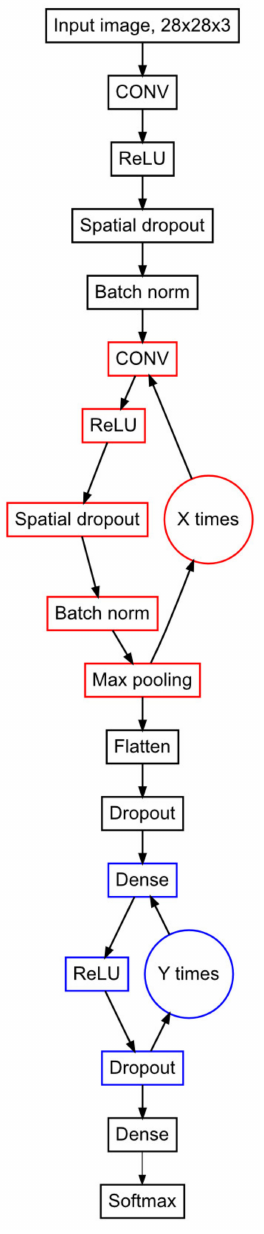
Figure 2. Flowchart of the convolutional neural network (CNN) model. CONV is a 2D convolutional layer with a L1 regularization factor of 1e-4. ReLU is the rectified linear activation function. Spatial dropout is a 2D spatial dropout layer, dropping entire 2D feature maps. Batch norm is a batch normalization layer, normalizing the activation of the previous layer at each batch. Numbers of iterations (X) of the convolutional layers loop (red) is defined by the Bayesian optimization (Table S4, convolutional loop iterations). For every iteration, the number of filters of the loop is doubled. The first and potentially second convolutional layers loop contains a 2D max pooling layer of size 2 × 2. The data are flattened (Flatten) after the convolutional layers loop. Individual element dropout (Dropout) is applied for the rest of the model. The dense layers loop (blue) applies a L2 regularization factor of 1e-4. The number of iterations (Y) of the dense layers loop is defined by the Bayesian optimization (Table S4, dense loop iterations). For every iteration, the number of units is doubled. The model is finalized with a dense layer with as many units as there are different categories of windows (3 in this model) and a Softmax activation